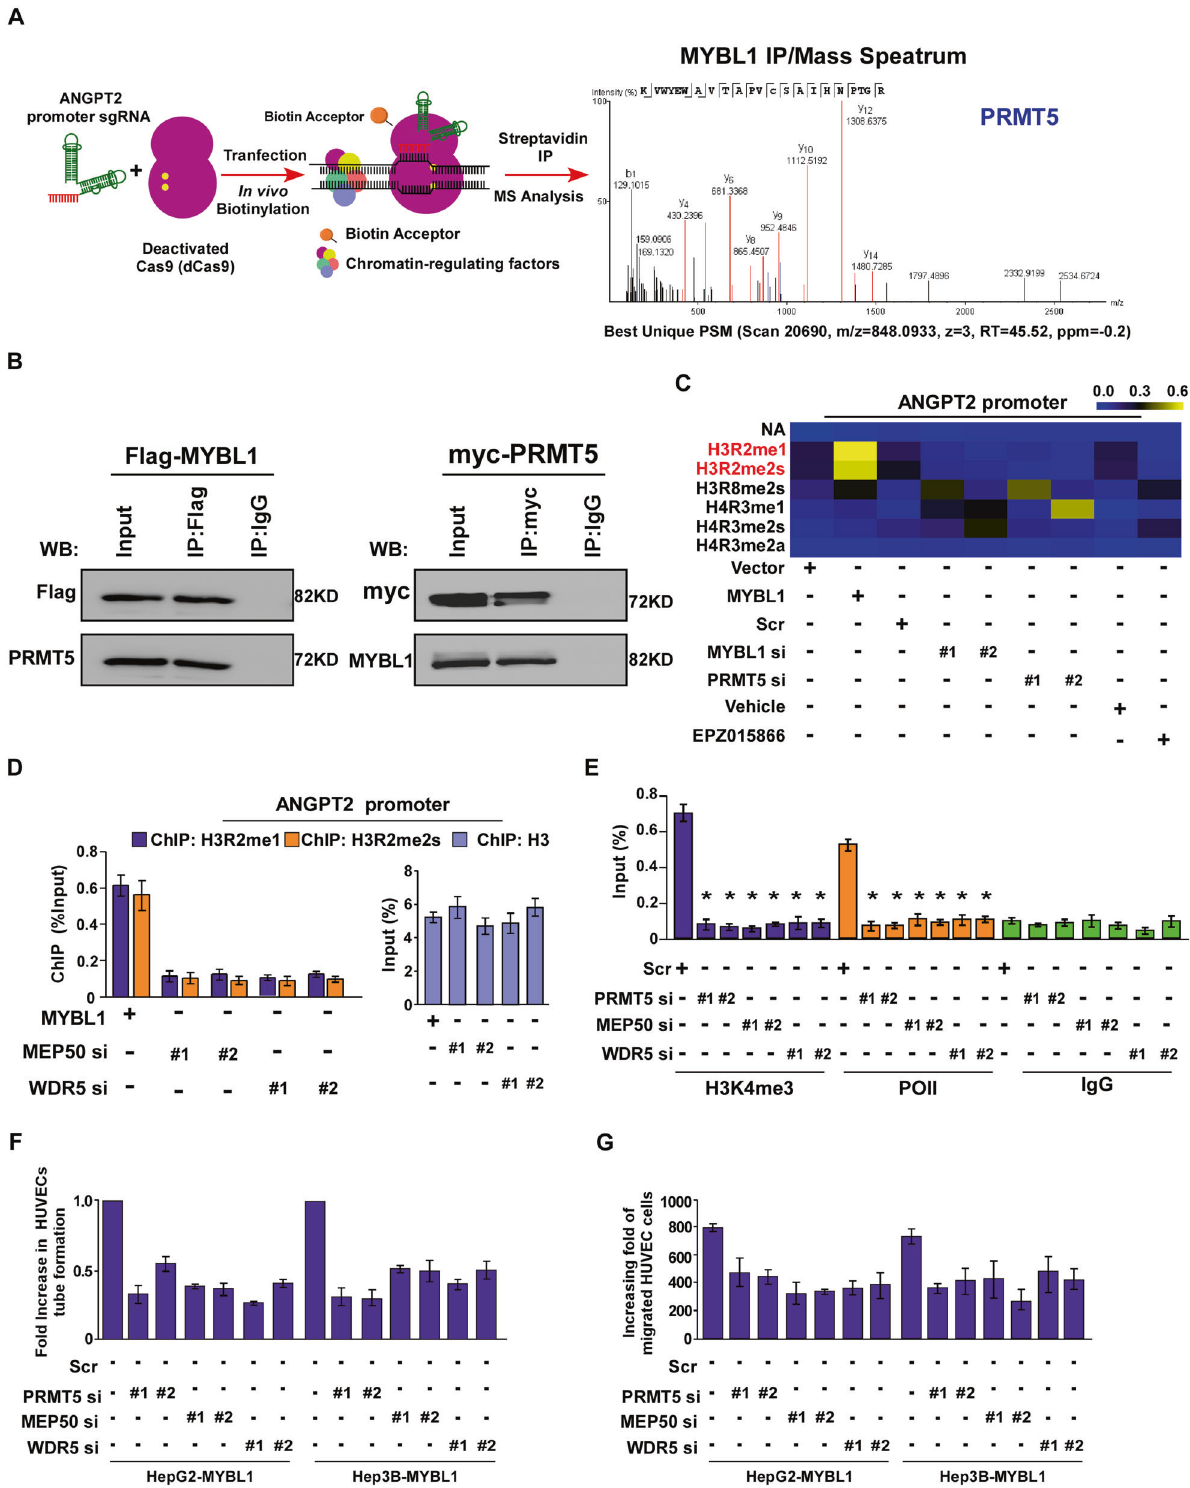
Fig. 6 The PRMT5/MEP50/WDR5 is involved in MYBL1-induced angiogenesis via epigenetically regulation of ANGPT2. A Schematic of dCas9-mediated capture of chromatin interactions between MYBL1 and PRMT5. B Co-IP assay showing that endogenous MYBL1 interacted with endogenous PRMT5 in HCC cells. C Heatmap of ChIP-qPCR enrichments of histone post-translational modi fi cations on MYBL1 promoter in the indicated cells. D ChIP-qPCR enrichments of H3R2me1 and H3R2me2s on ANGPT2 promoter region in the indicated group. E ChIP-qPCR enrichments of H3K4me3, polymerase II, or IgG on ANGPT2 promoter region in the indicated group. F Quanti fi cation of HUVEC tube formation cultured on Matrigel-coated plates in the indicated group. G Cell migration assay was performed by culturing HUVEC with conditioned media in the indicated